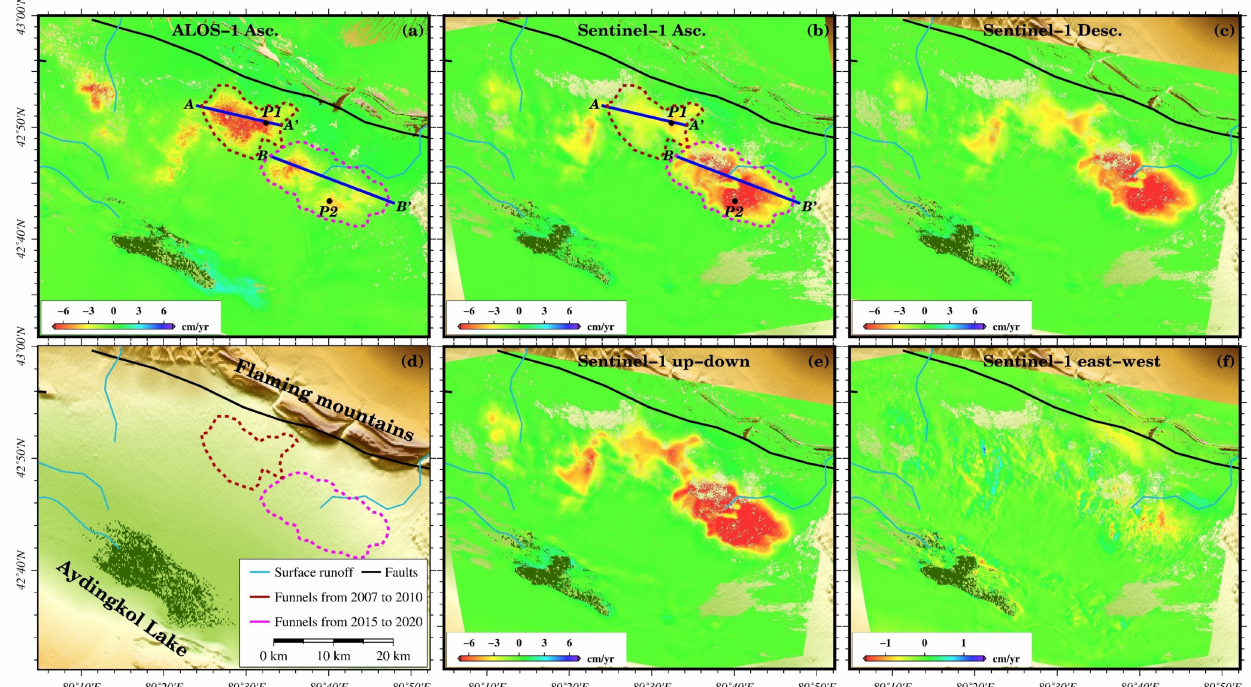
Figure 4. Deformation rate along LOS directions from ( a ) ALOS-1/PALSAR, ( b ) ascending track Sentinel-1, and ( c ) descending track Sentinel-1 data. Negative values indicate the direction away from the SAR satellite, while positive values indicate the opposite. ( d ) The hydrogeology of this area. ( e , f ) The deformation rate along the up–down and east–west directions calculated from as- cending/descending tracks Sentinel-1 data. The red dotted line delineates the central area of the subsidence funnels from 2007 to 2010. The magenta dotted line delineates the central area of the subsidence funnels from 2015 to